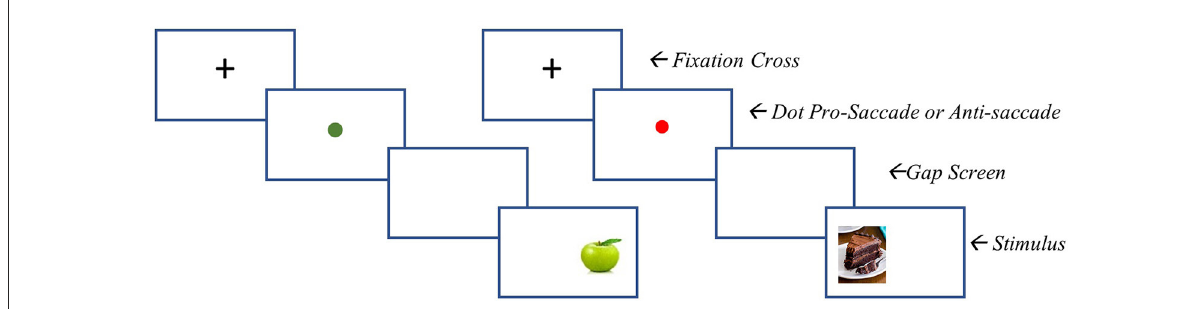
FIGURE1 ABMT stimulus presentation. Left = pro-saccade stimulus presentation (i,e., participant is to look toward the food image presented). Right = anti-saccade stimulus presentation (i,e., participant is to move their gaze away from the stimulus).